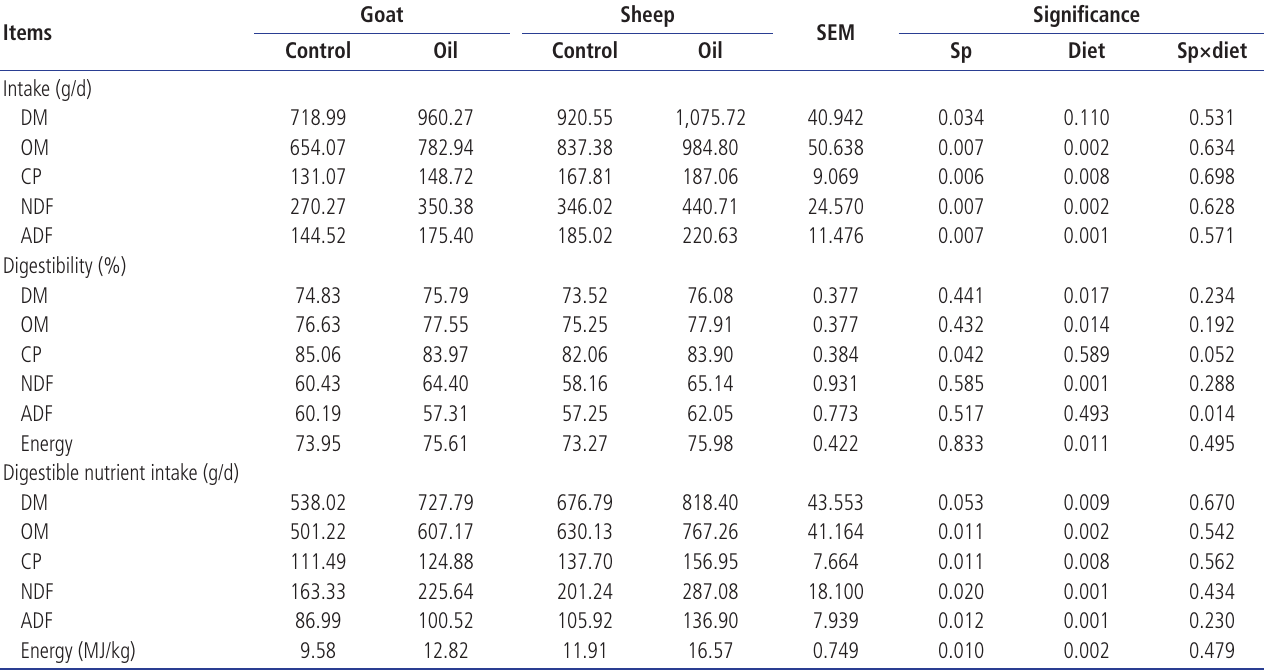
Table 4. Nutrient intake, apparent nutrient digestibility (%) and digestible nutrient intake of goat and sheep fed high concentrate diet with and without linseed oil supplementation Goat Sheep Items